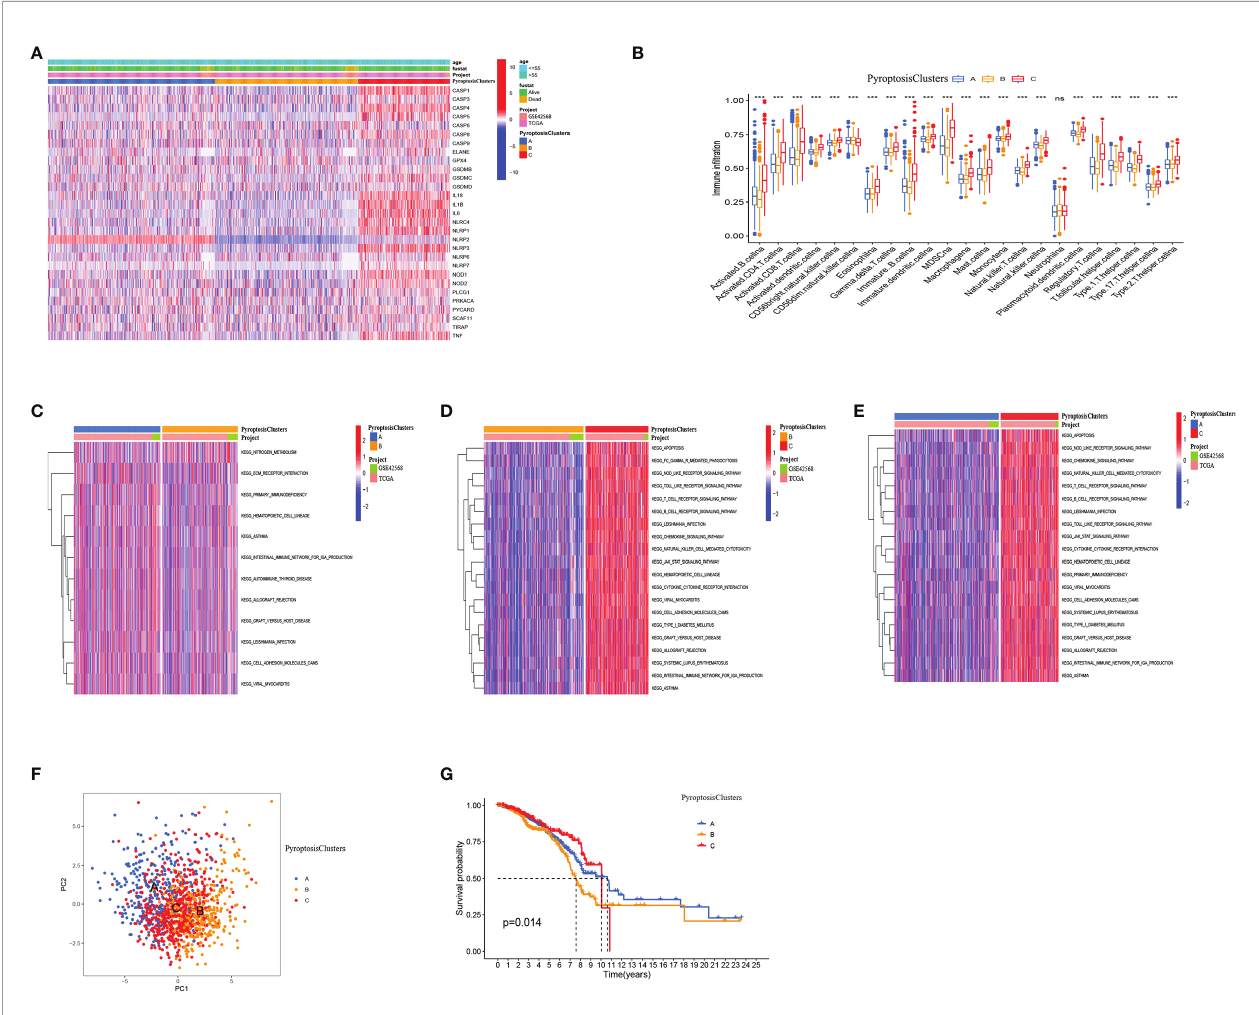
FIGURE 3 | Pyroptosis patterns mediated by 33 pyroptosis-related genes in BRCA. (A) Heat map of the clinical relevance of three pyroptosis subtypes. (B) The abundance of each TME in fi ltrating cell in three PyroptosisCluster. (C – E) GSVA enrichment analysis showing the activation states of biological pathways in different pyroptosis modi fi cation patterns. The heat map was used to visualize these biological processes, and red represented activated pathways and blue represented inhibited pathways. (F) Principal component analysis (PCA) analysis of pyroptosis methylation modi fi cation pattern. (G) The overall survival of pyroptosis methylation modi fi cation pattern using Kaplan – Meier curves. * P < 0.05, ** P < 0.01, *** P < 0.001; NS, Non Signi fi